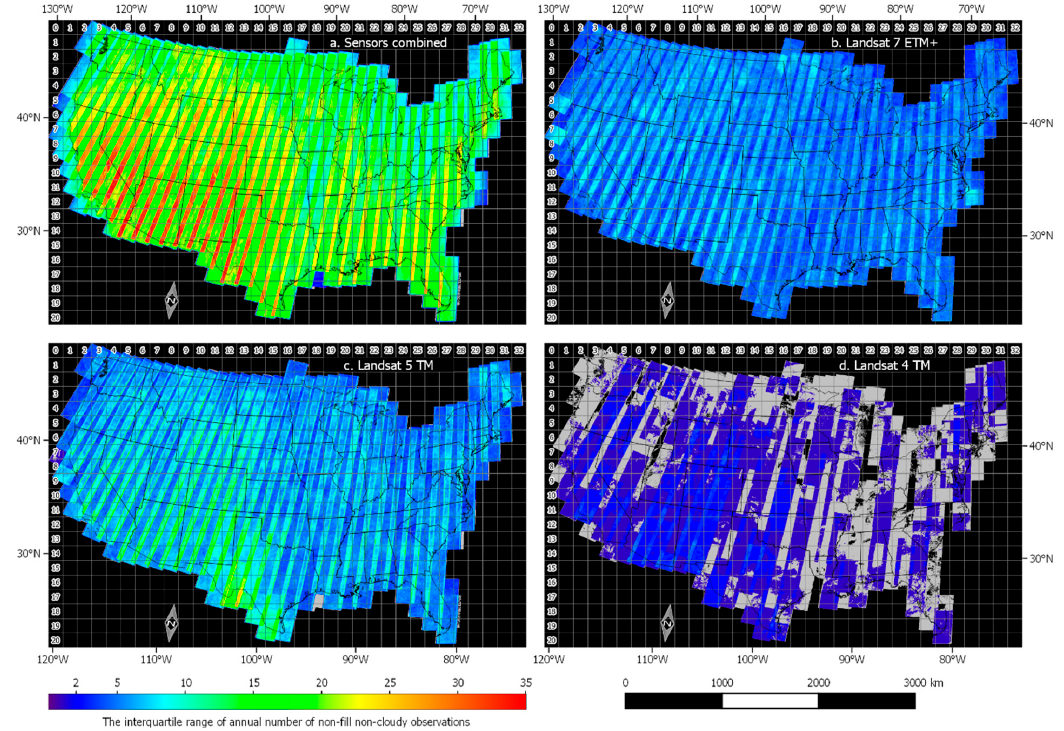
Figure 7. The interquartile range ( IQR sensor Equation (2)) of the annual number of non-fill non-cloudy pixel observations at each CONUS ARD 30 m pixel location for (a) Landsat 4 TM, 5 TM and 7 ETM+ combined, (b) Landsat 7 ETM+, (c) Landsat 5 TM, (d) Landsat 4 TM. The maximum CONUS ARD IQR sensor values are 55 ( a ), 27 ( b ), 31 ( c ) and 6 ( d ). Light grey show locations where there were pixel